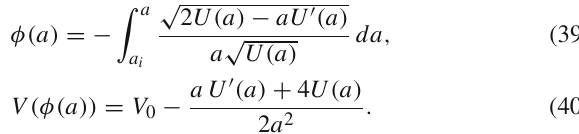
Fig. 4 Upper graph: The scale factor potential U ( a ) of the parameteri- zation(32).Lowergraph:Thecorrespondingscalar-fieldpotential V (φ) of (45), normalized by its value at ∞ . We use units where 8 π G = 1 and we set the scale factor at the beginning of inflation to a i = 1. We consider e-folding number N f = 60, and thus (33) gives N 0 = − 59. Inflation ends at the global minimum of U ( a